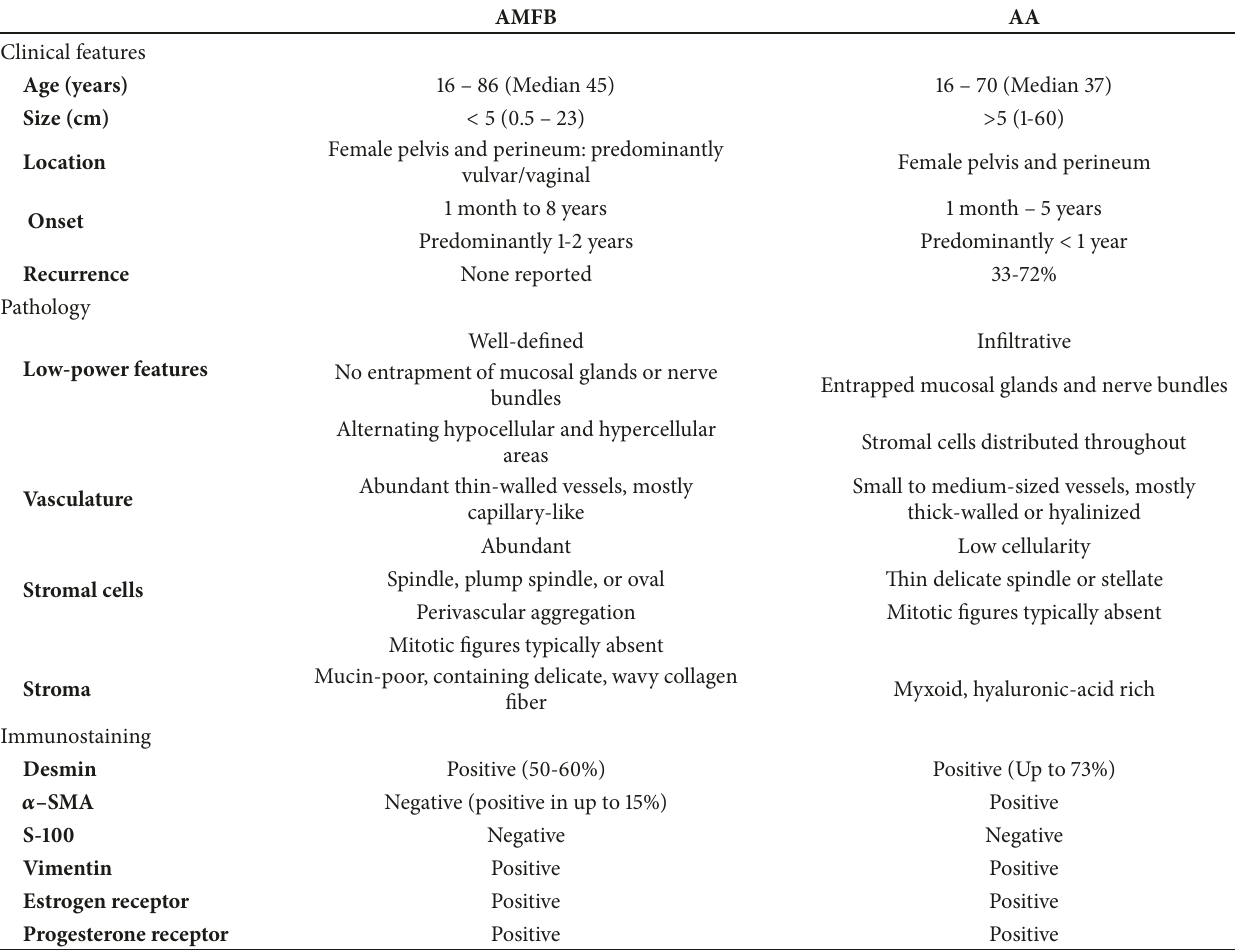
Table 1: Clinical and pathologic features of AMFB and